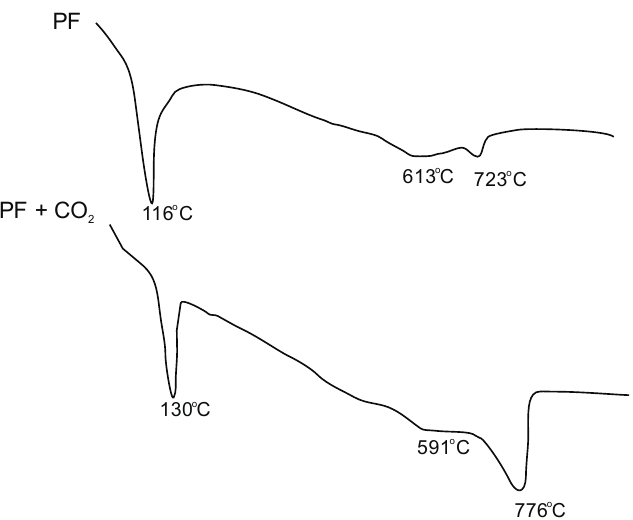
Figure 4. DTA curves for suspensions of PF FBC fly ashes: clean (PF) and treated with CO 2 (PF with CO 2 ).